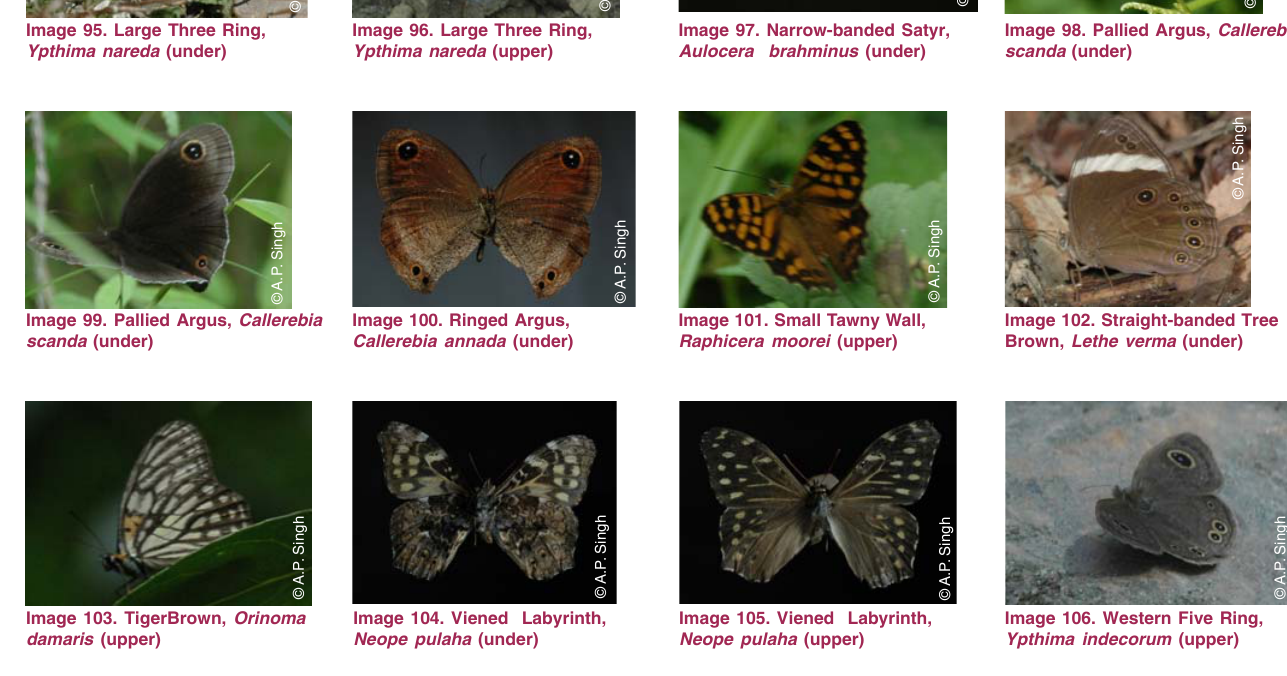
Image 95. Large Three Ring, Ypthima nareda (under)